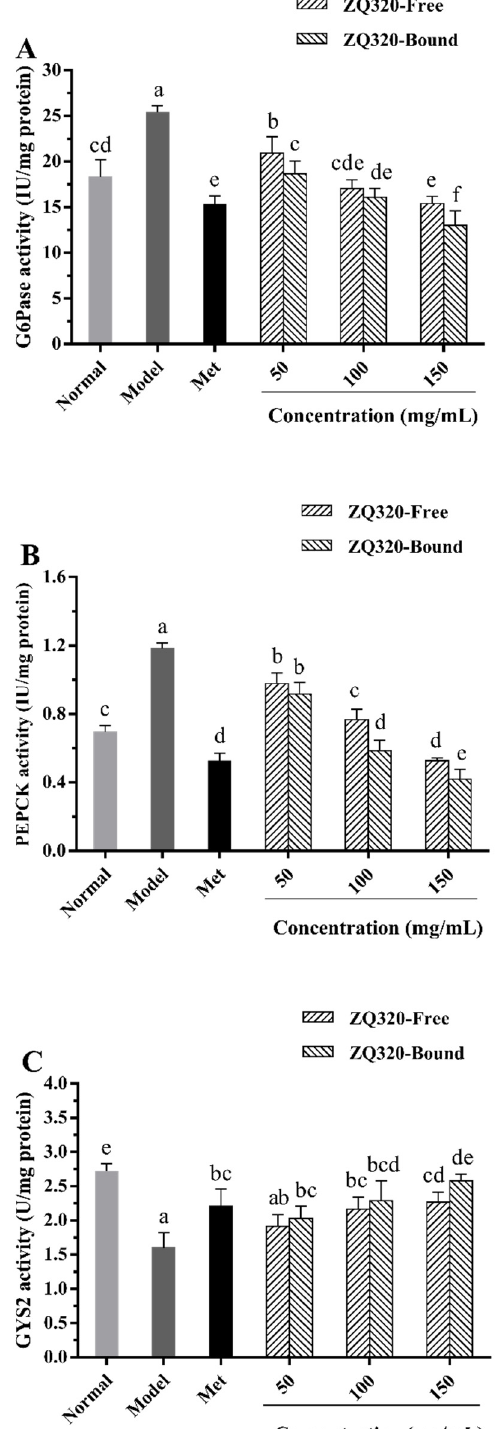
Figure 4. The concentration of glucose- 6-phosphatase (G6Pase) ( A ), phosphoenolpyruvate carboxykinase (PEPCK) ( B ), and glycogen synthase 2 (GYS2) ( C ) activities of HepG2 cells in free and bound fractions of ZQ320 highland barley variety (mean ± SD, n = 3). Values with different letters in each bar differ significantly at p < 0.05.